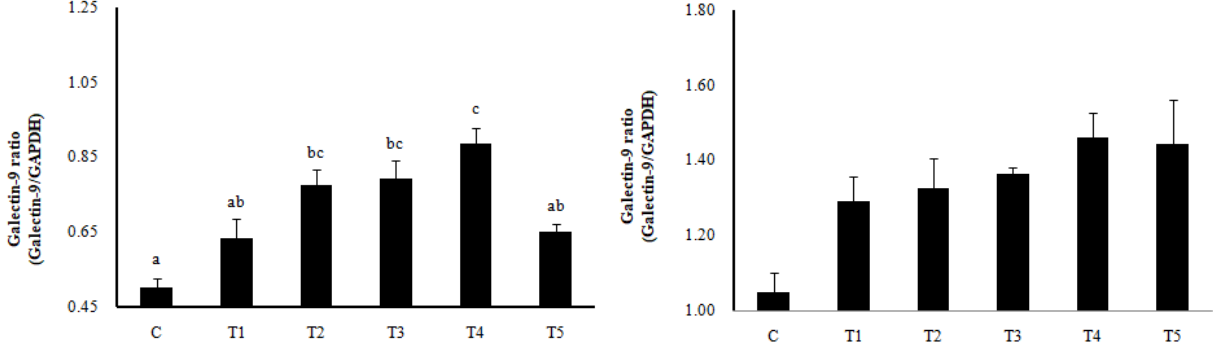
Figure 1. Galectin-9 expression in mesenteric lymph nodes (MLN, left) and spleen (right) by RT-PCR analysis. Data represent means±standard de- viations of 8 replicates. RC -LAB, Rubus coreanus -derived lactic acid bacteria; C, control; T1, 1% RC -LAB fermented feed; T2, 2% RC -LAB fermented